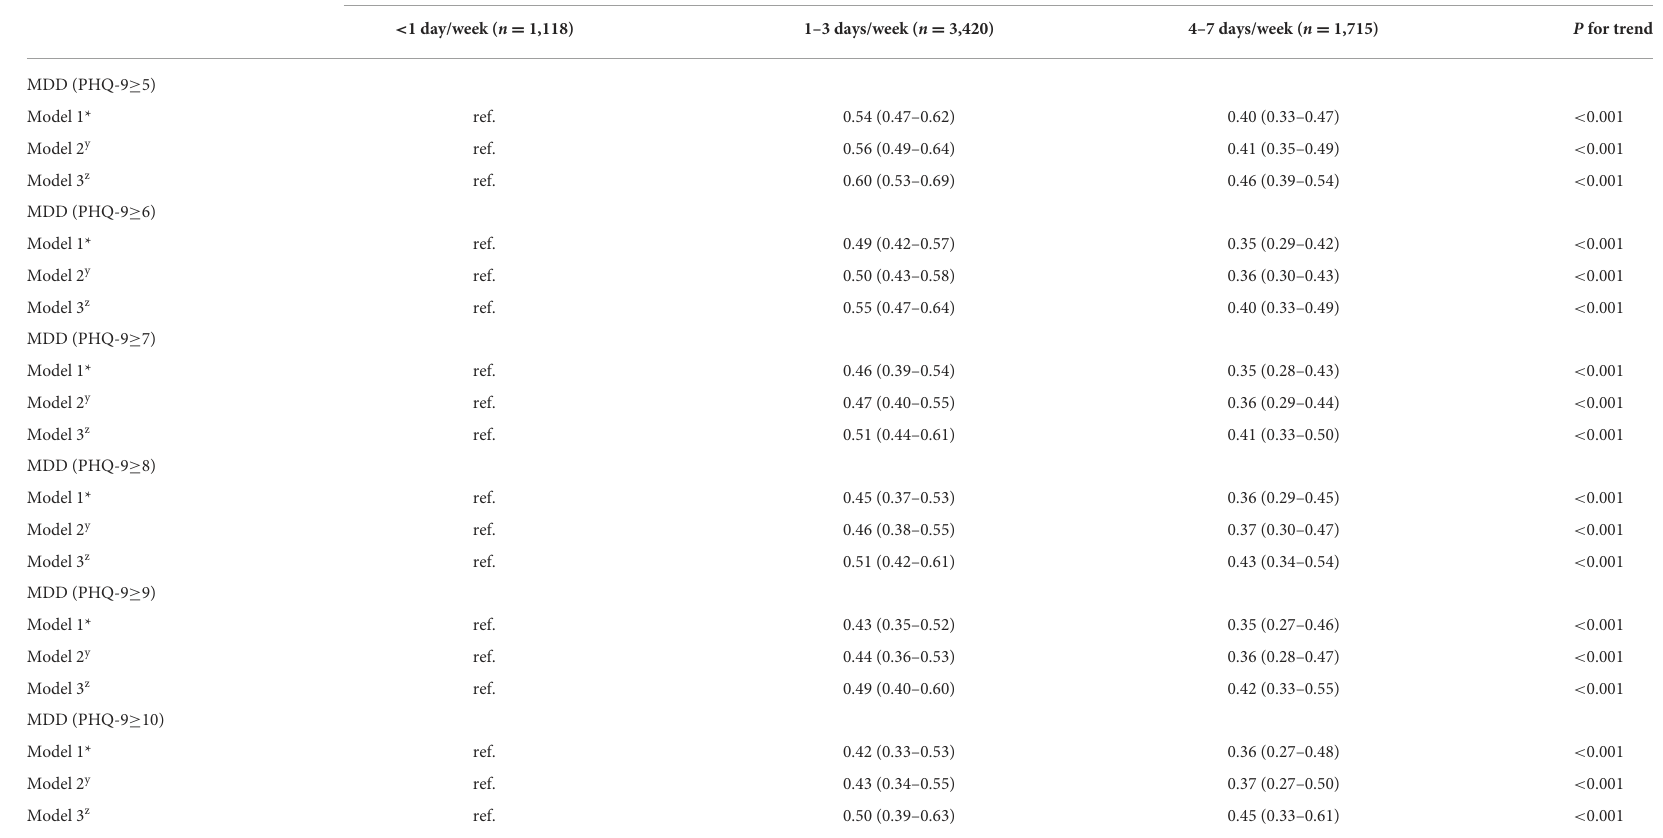
TABLE 2 Adjusted association between soy products consumption and